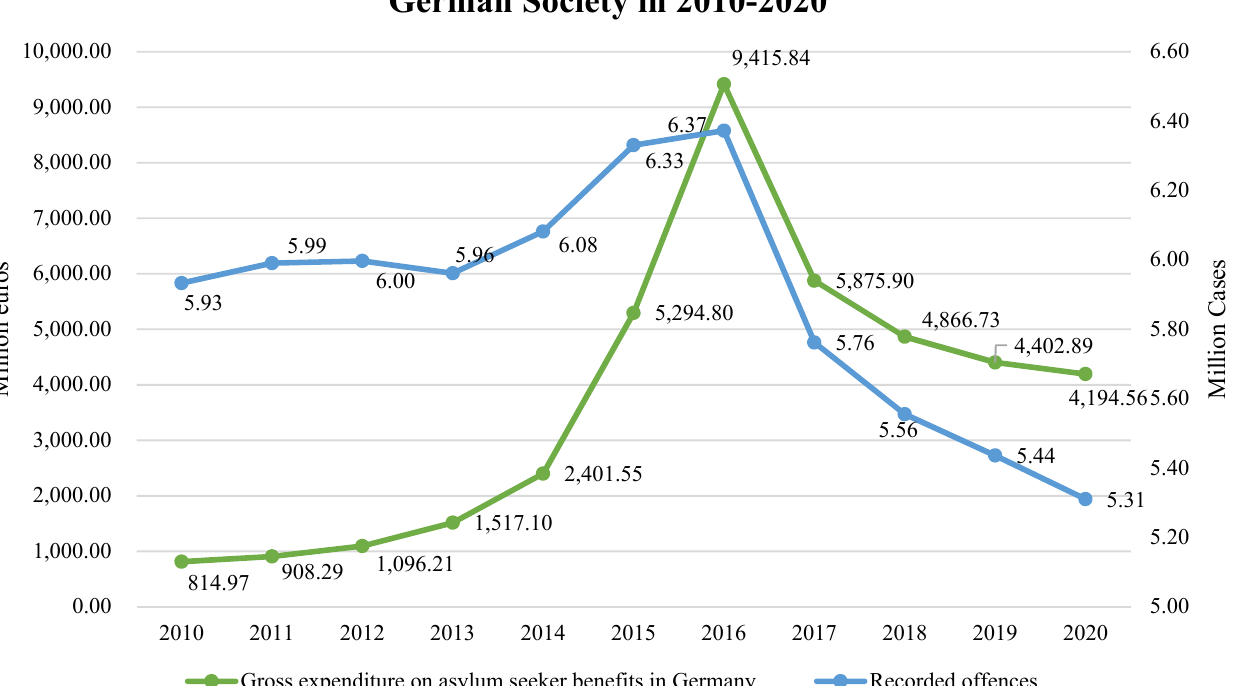
Figure 4. Refugee population in Germany (2006–2020). Source from Our World in Data, line graph made by authors.